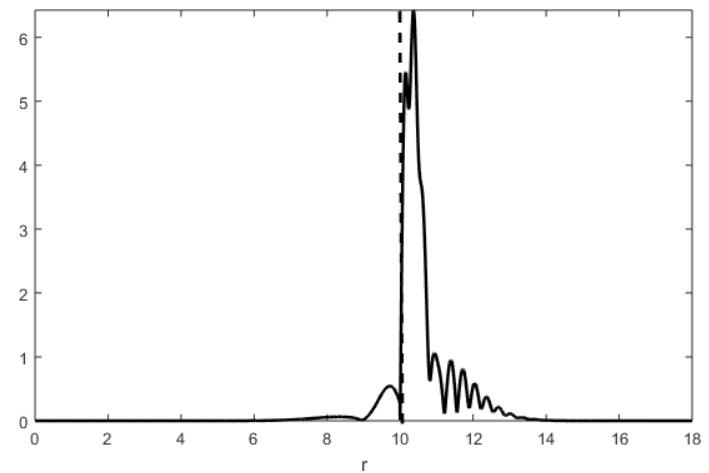
Figure 6. Solution profile then interacting with the defect for Z = 200 at t = 0.2645.